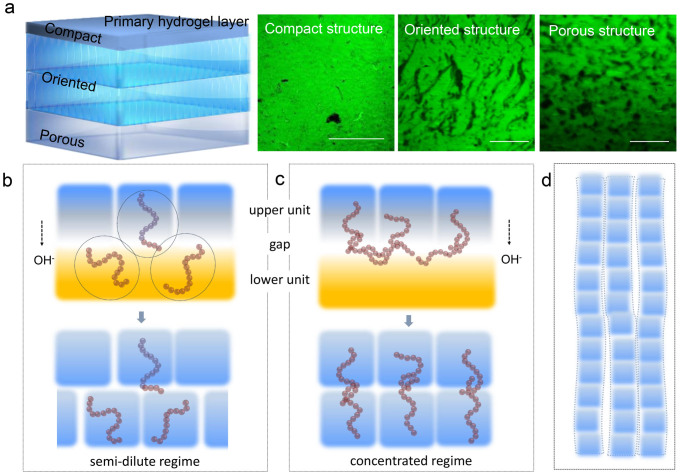
Schematic model of layered-oriented CS hydrogel and illustration of formation mechanism.(a) Schematic model, CLSM images corresponding to compact region, oriented region and porous region, respectively, c(CS) > 1.0 wt.%, scale bar represented 100 μm. (b)–(d) Macromolecular interactions in “gel-sol consecutive reaction units” during the gelation process, (b) semi-dilute regime, (c) concentrated regime, and (d) formation of oriented structure by stacking of reaction units.